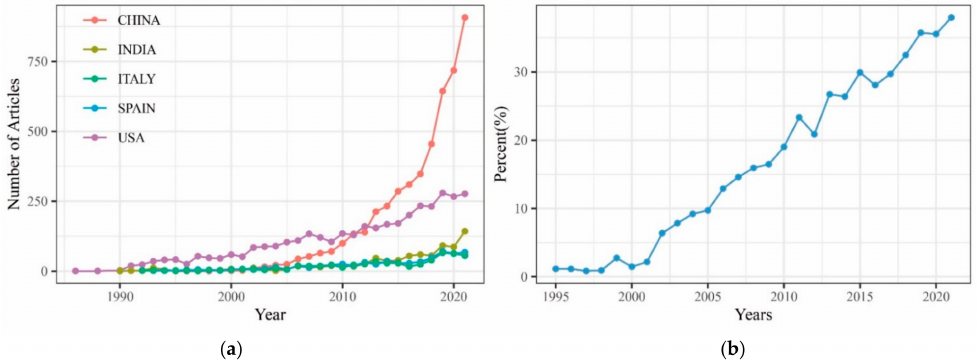
Figure 4. ( a ) Top five countries according to annual scientific production; ( b ) annual proportion of China’s scientific production.